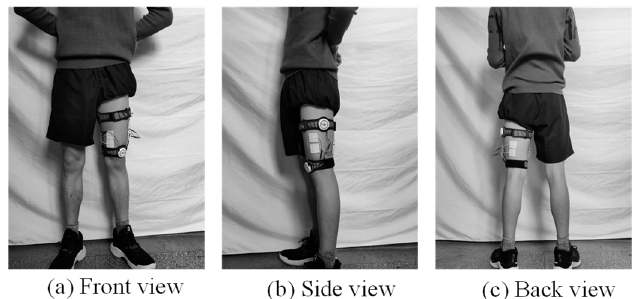
Figure 1. Acquisition scenario.